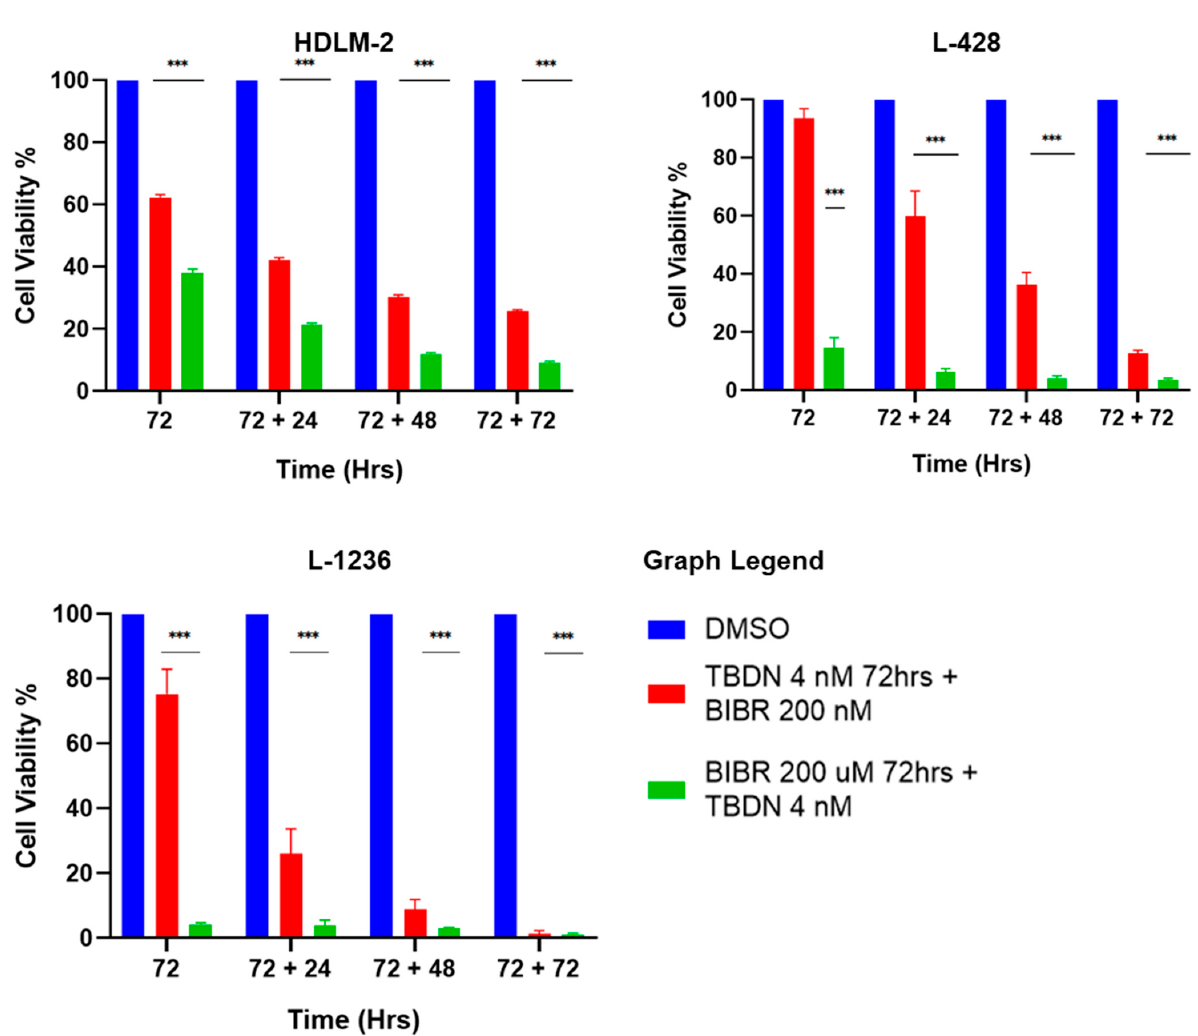
Figure 4. Consecutive inhibition of telomere maintenance pathways. HL cell lines show pronounced reduction in cellular viability over cell sensitization with trabectedin 4 nM and BIBR 200 µM for 72 h, followed by consecutive treatment with trabectedin 4 nM and BIBR 200 µM for 72 h. Data expressed as mean ± SEM. *** p < 0.0001. TBDN—trabectedin.